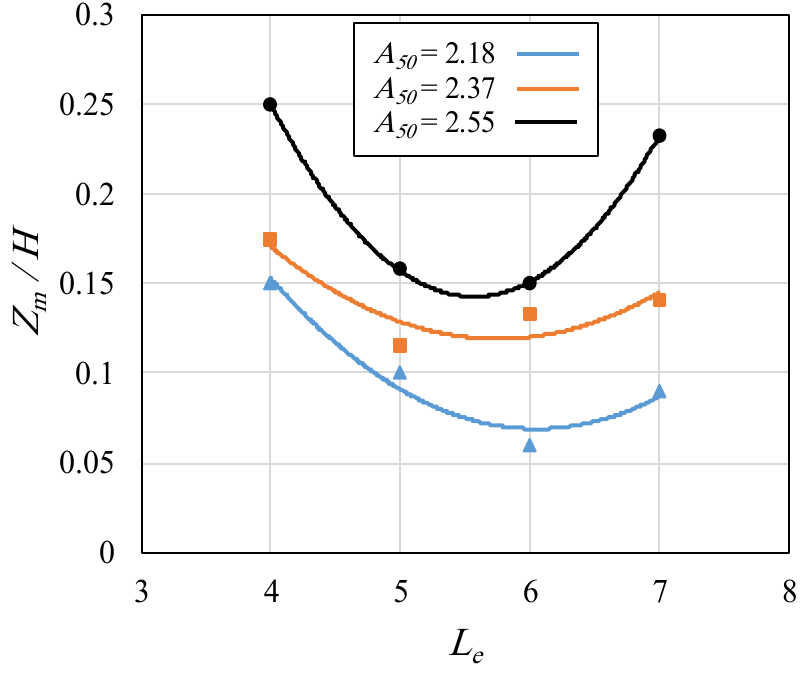
Figure 16. Variation of the maximum scour depth of thalweg with distances at different hydraulic conditions.